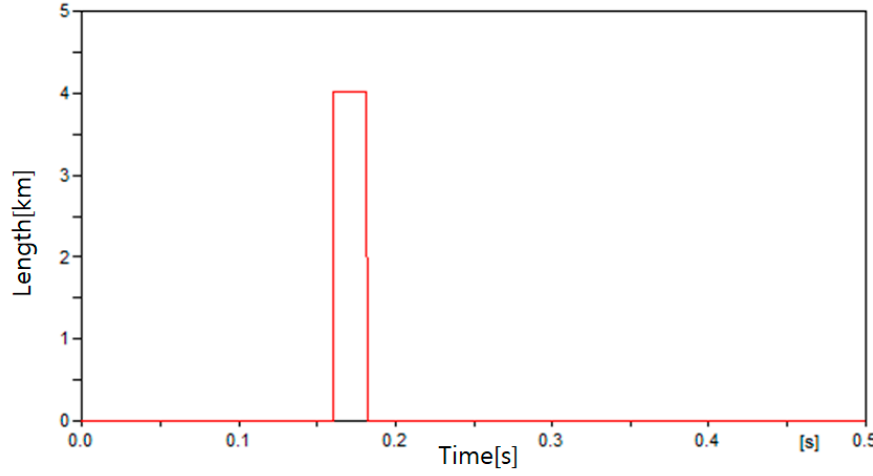
Figure 22. Fault location in Case 6.